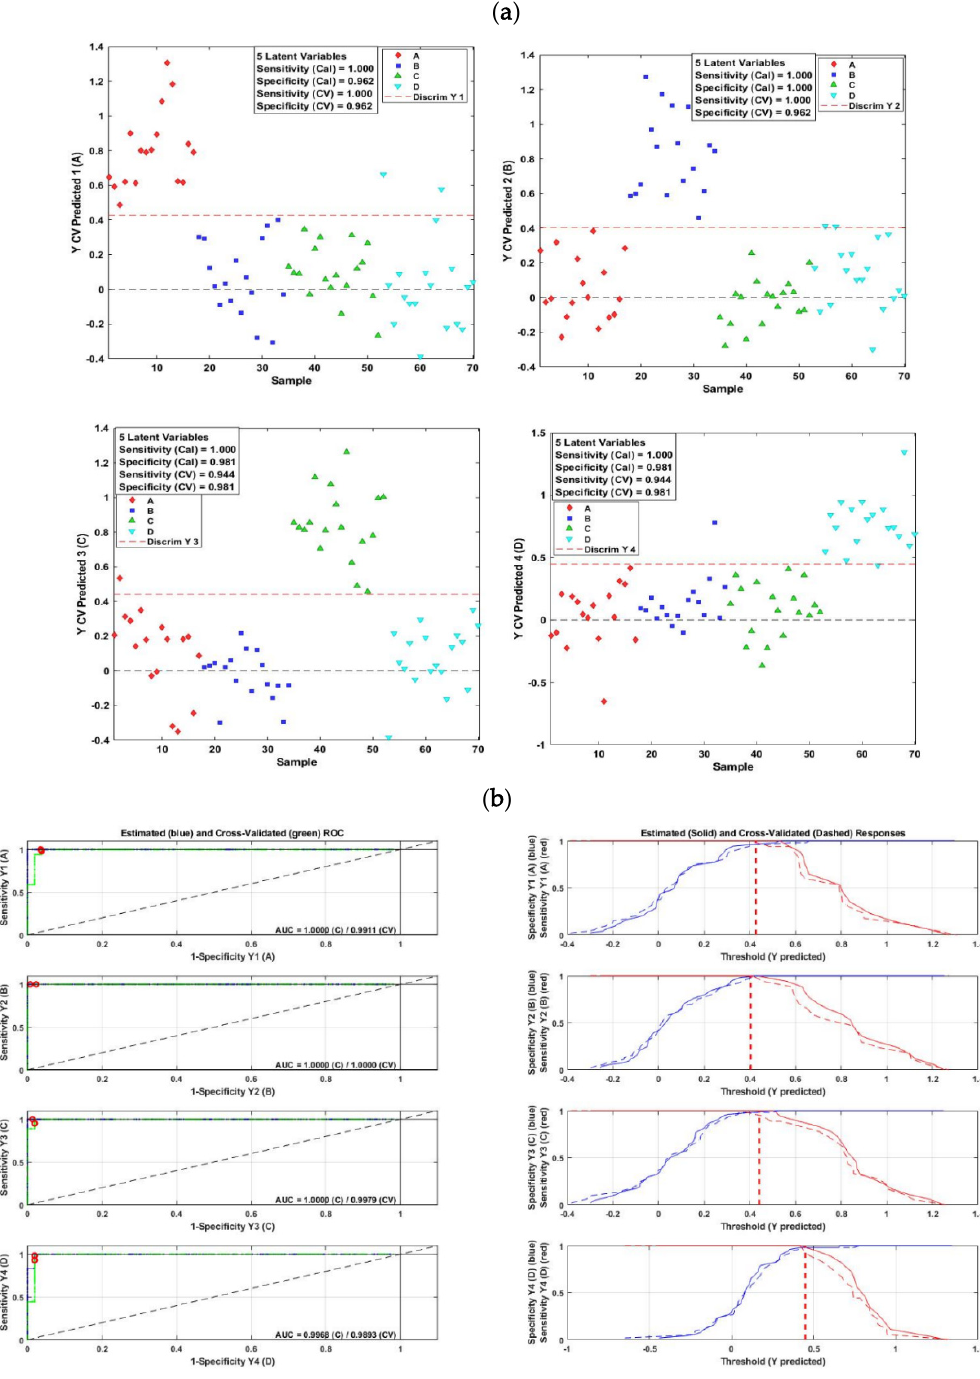
Figure 5. Partial least square discriminant analysis (PLS-DA) results obtained from the online diffuse reflectance hyperspectral imaging measurements of the four brands: Cross-validated predicted brand (a) and ROC plots (b).